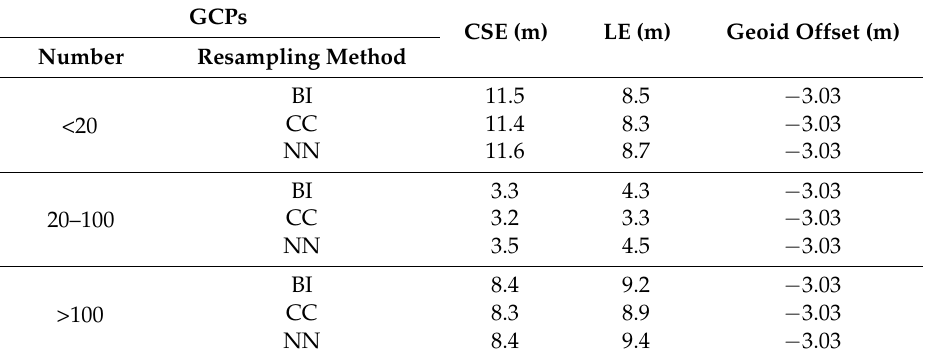
Table 5. Accuracy assessment for different number of GCPs with three resampling